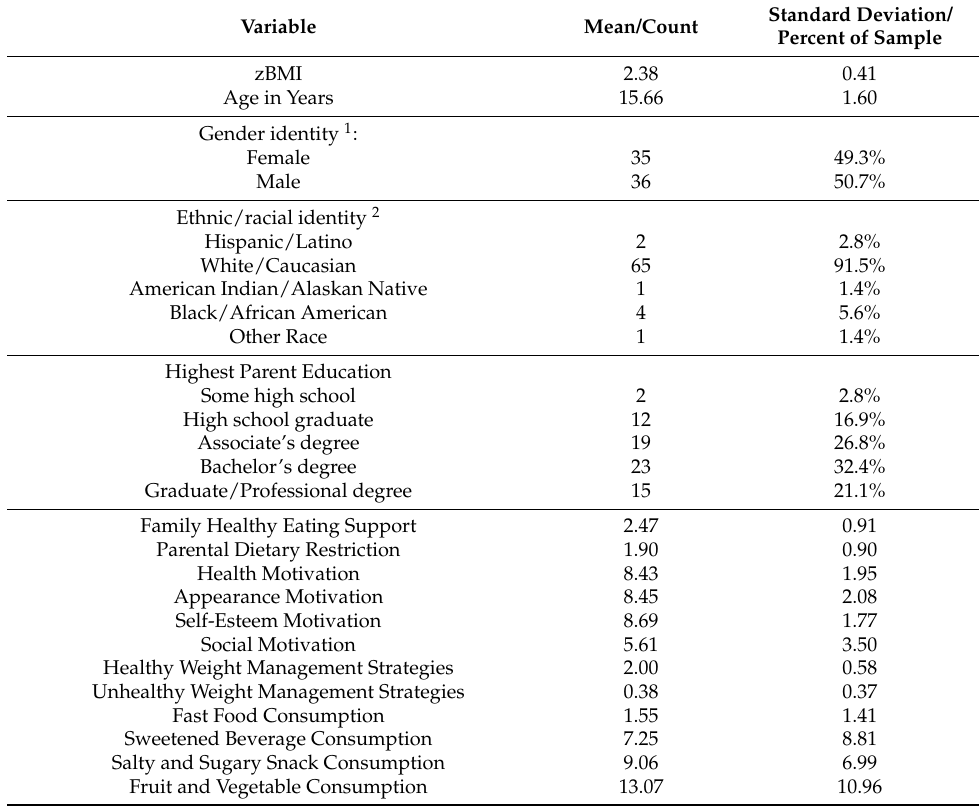
Table 1. Participant demographics and psychosocial